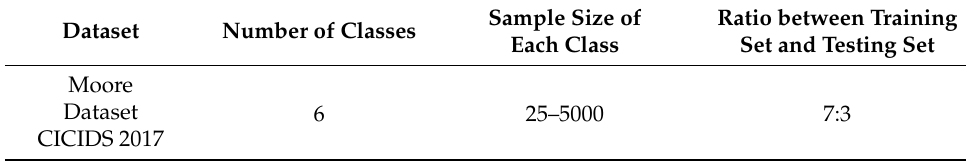
Table 3. Dataset Settings.